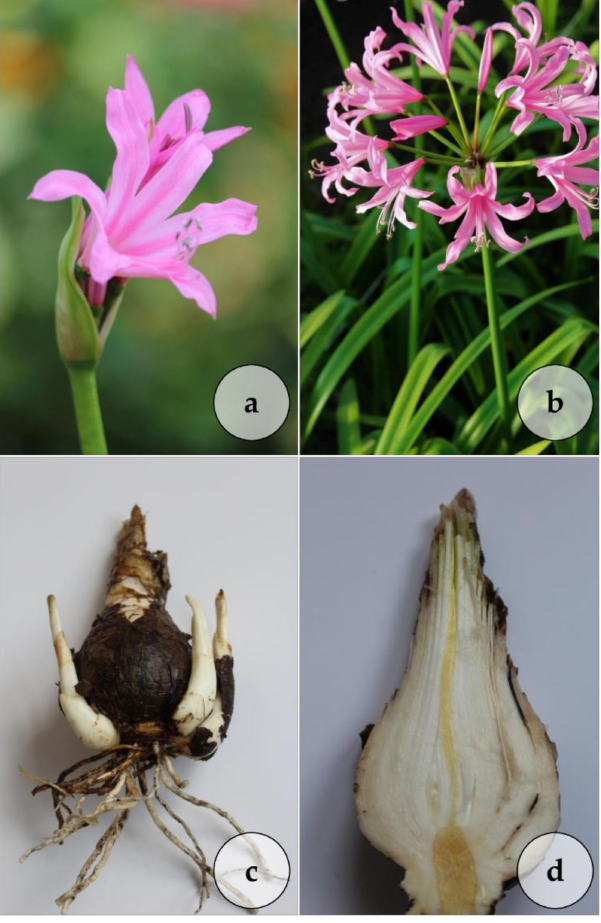
Figure 1. An inflorescence of × A. tubergenii ( a ) and in full anthesis ( b ). Perennial bulb of × A. tubergenii with daughter bulbs ( c ) and a longitudinal section through a dormant bulb ( d